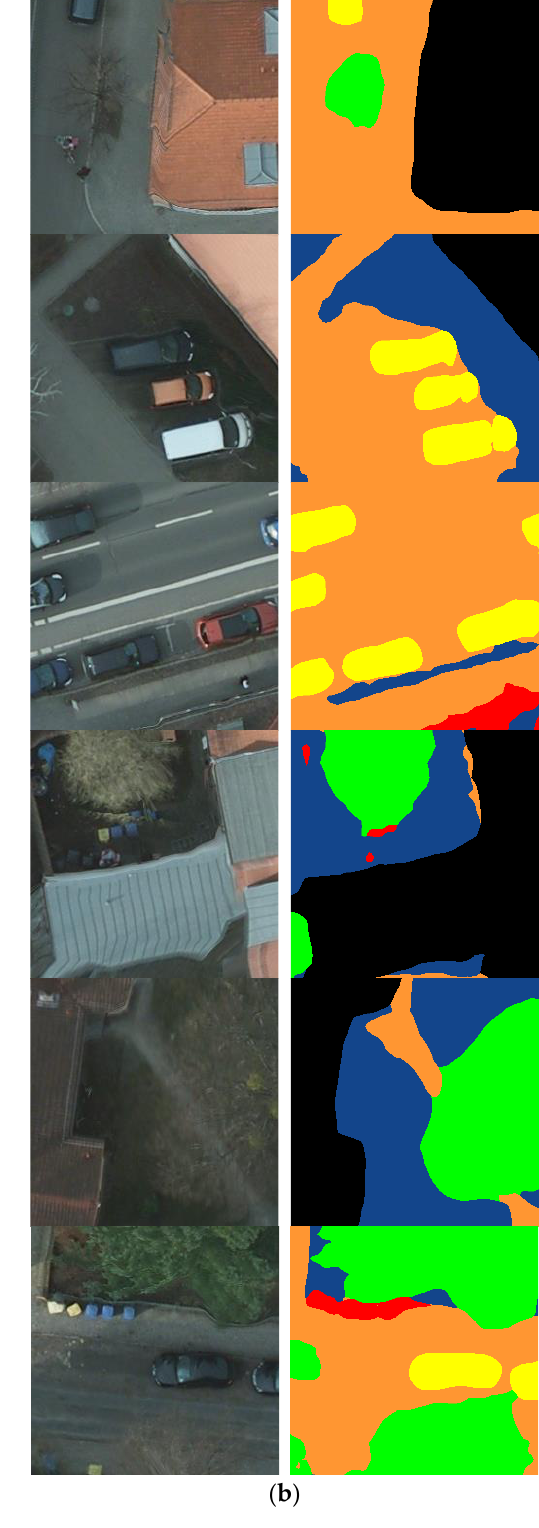
Figure 17. Prediction details of the test images are provided by LPASS-Net in ( a ) the BDCI 2017 dataset and ( b ) the ISPRS Potsdam dataset, where the category details are shown in Table 8.